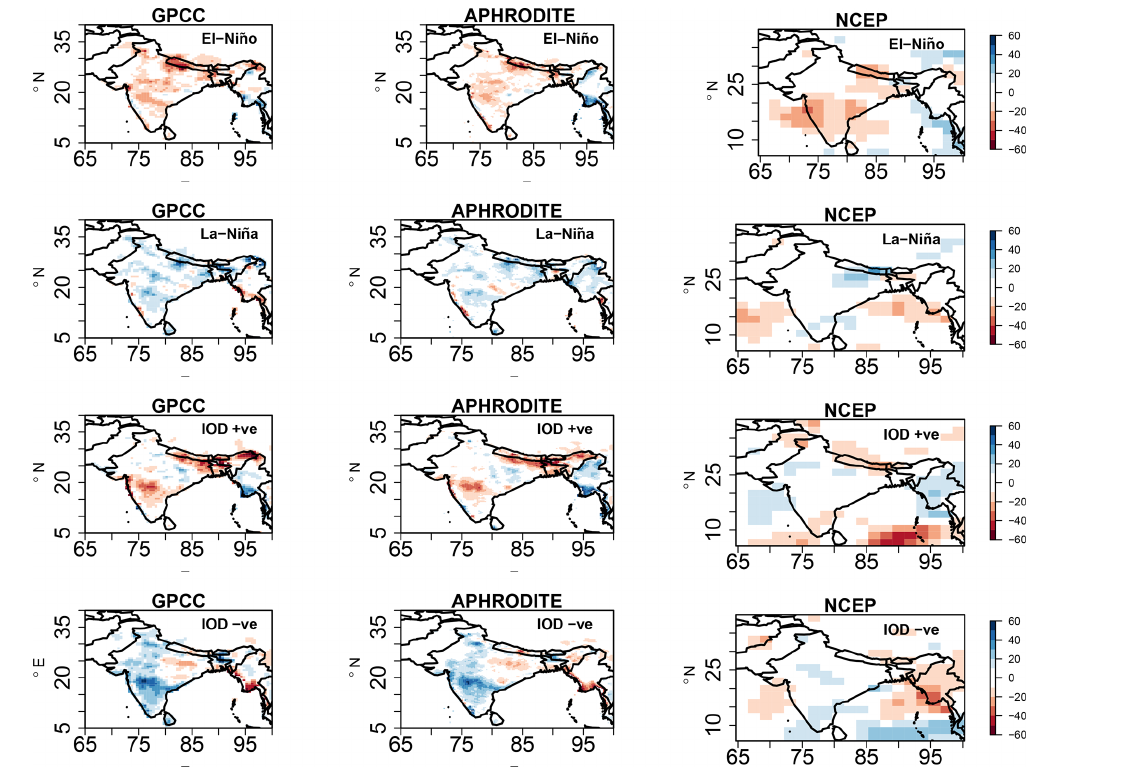
Figure 4. Total precipitation anomaly (millimeters per month) composites (JJAS) over the Indian subcontinent for El Niño, La Niña, and positive IOD and negative IOD events observed in GPCC, APHRODITE, and NCEP reanalysis datasets for the period of